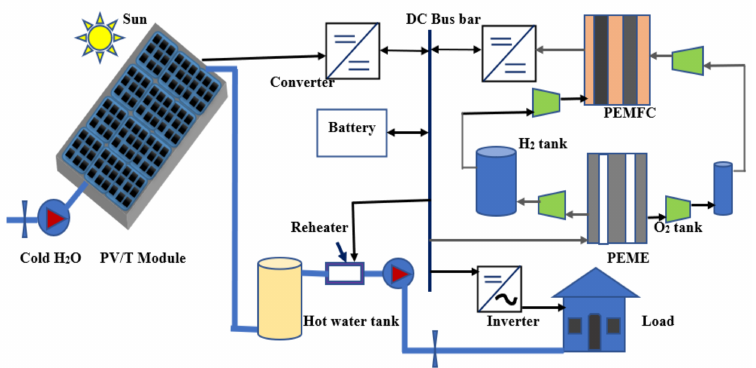
Figure 3. Schematic diagram of an IPVFC system including a PV/T, battery, electrolyser and fuel cell [38].